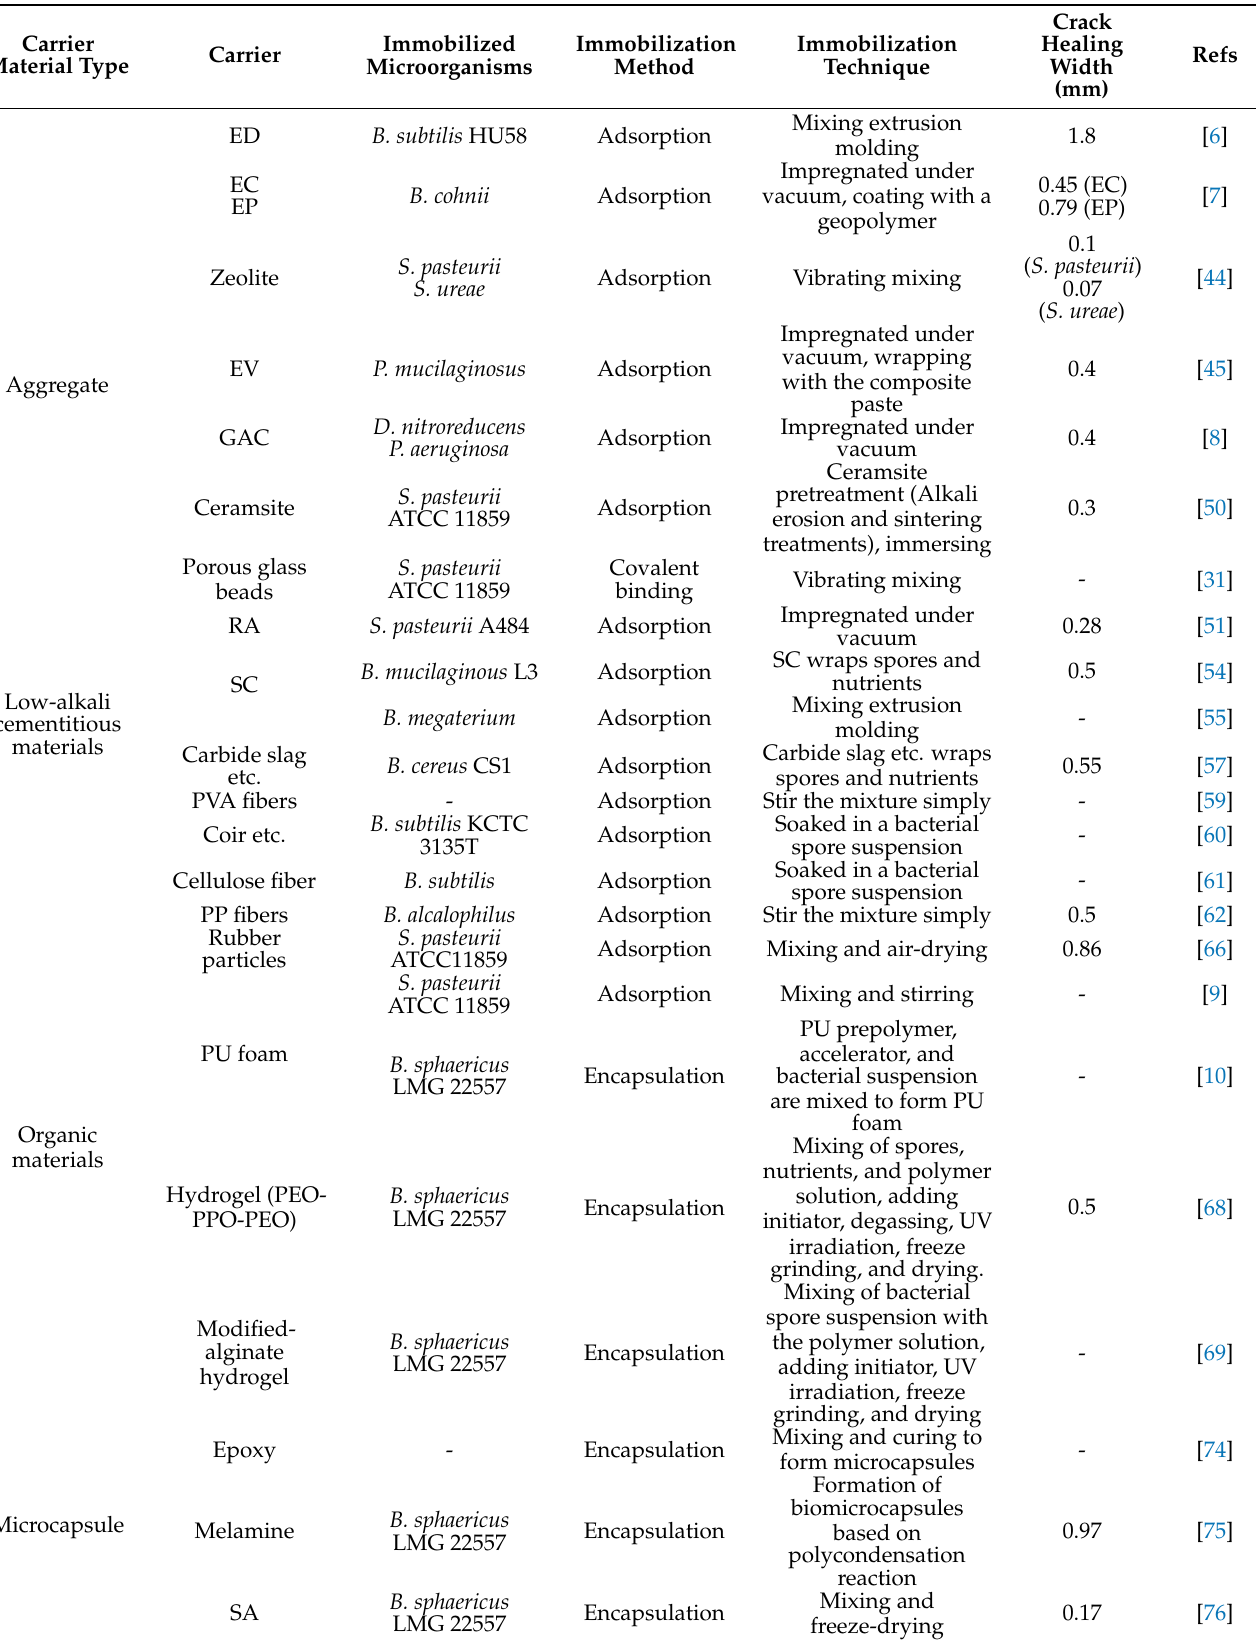
Table 2. Summary of bacterial carrier